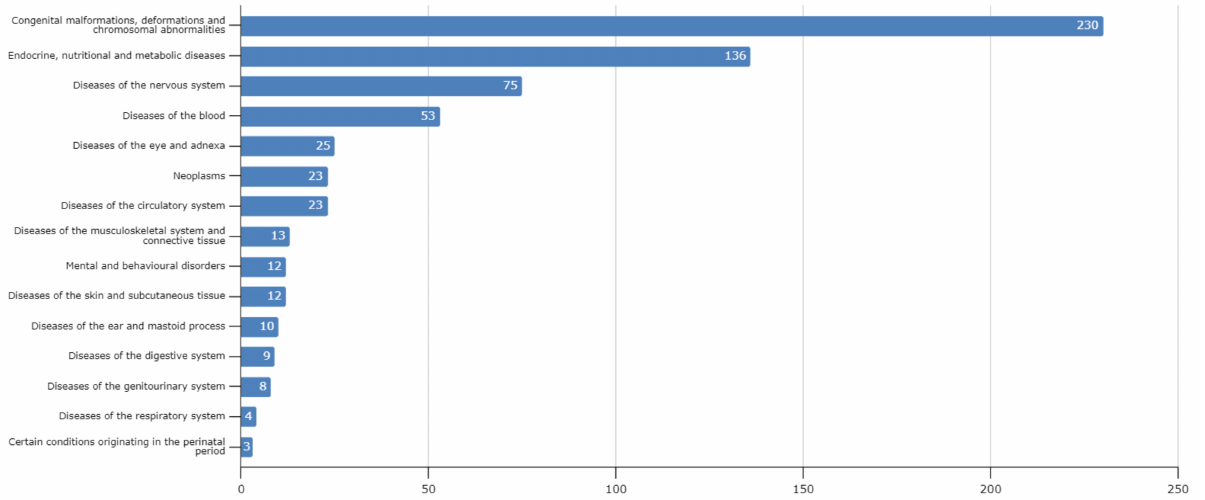
Figure 3. WHO ICD-10 classification of diseases reported in Lebanese subjects in CTGA. X-axis denotes number of disease entries in each